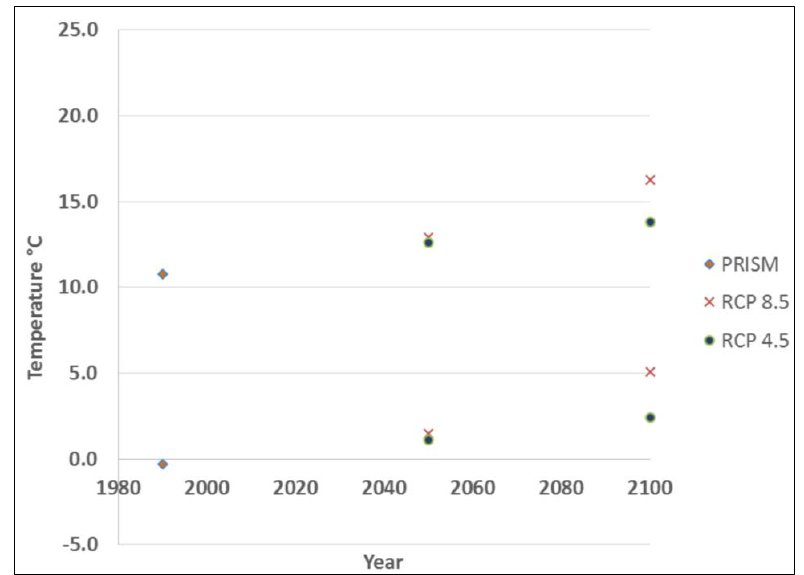
Figure 4. Thirty year normal minimum and maximum temperature for: PRISM data (1990), RCP 4.5 (2050, 2100), and RCP 8.5 (2050, 2100).